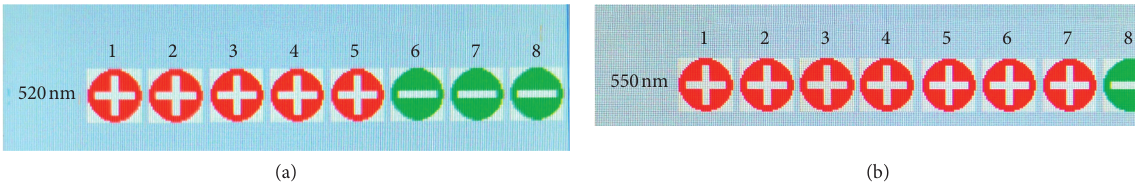
Figure 2: Representative results displayed during sensitivity evaluation. (a) and (b) Sensitivity analysis for Salmonella and Shigella, re- spectively. Samples 1 to 8 were Salmonella and Shigella from 10 7 CFU/mL to 10 0 CFU/mL.